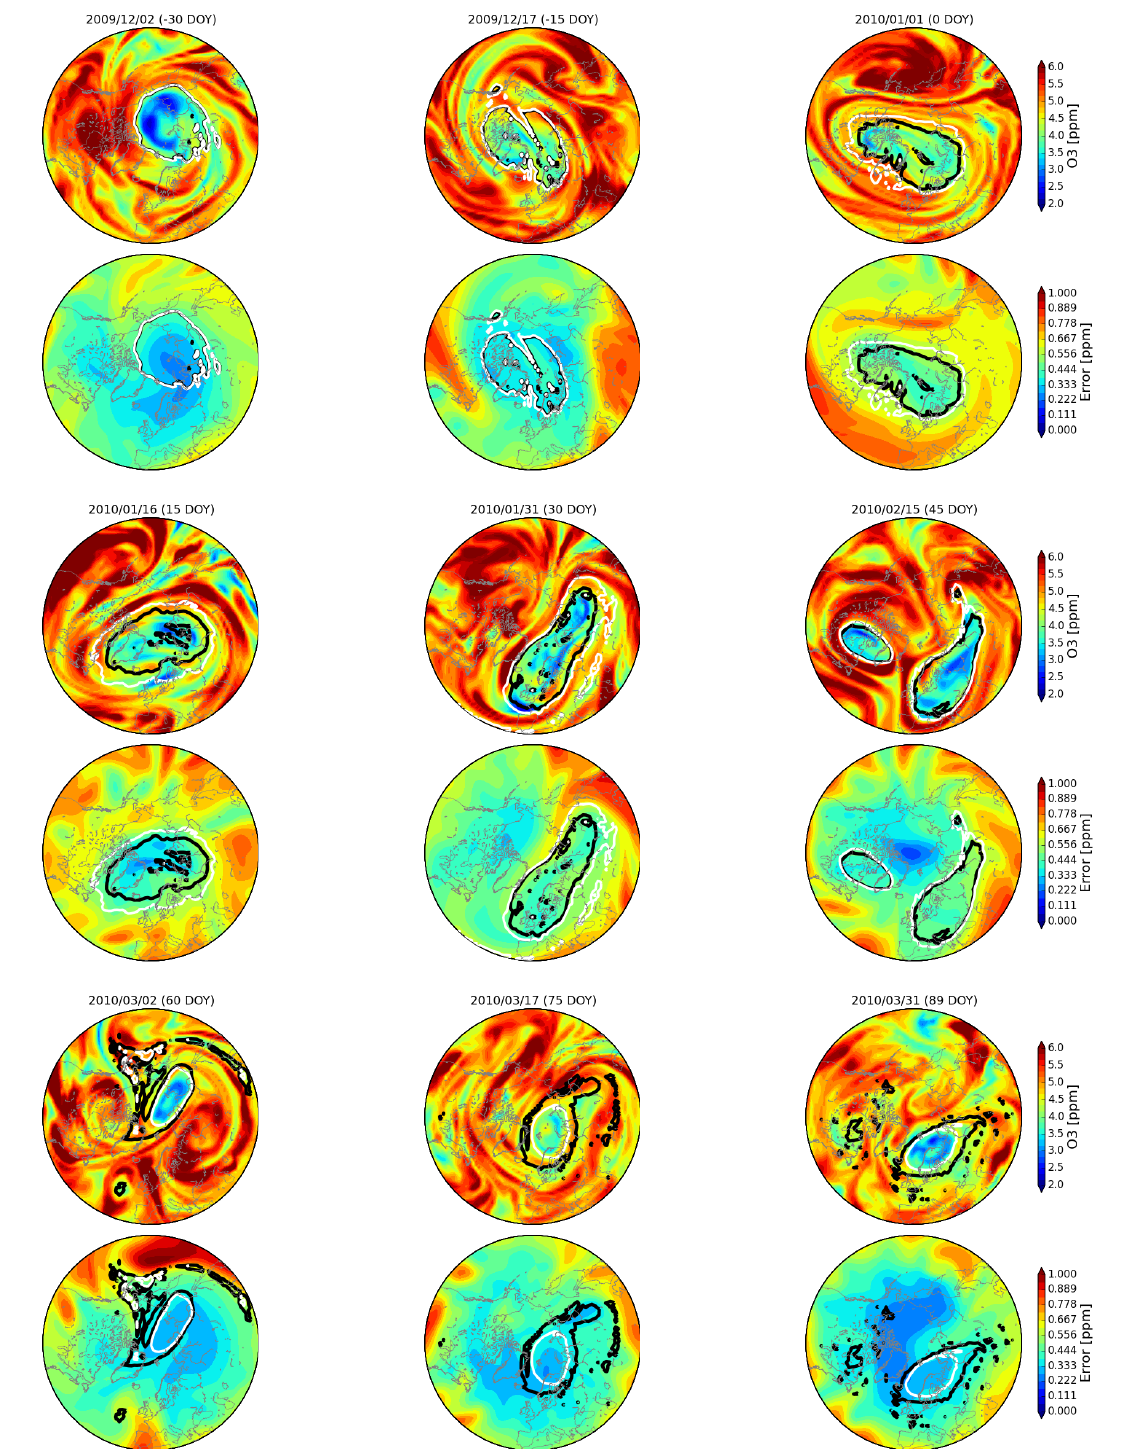
Figure 8. Same as Fig. 4 but for ozone derived from SMR. Fig. 8: Same as figure 4 but for ozone derived from SMR. 24